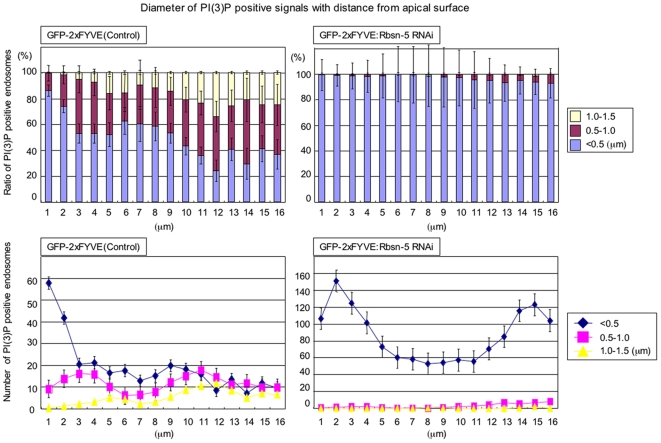
The number of basolateral large PI(3)P-positive endosomes was decreased in Rbsn-5 knockdown pupal wings.Ratios (upper) or numbers (lower) of small (<0.5 µm, blue), middle (0.5–1.0 µm, red) and large (1.0–1.5 µm, yellow) endosomes are shown for repeated 1 µm sections from the apical to basal region in the wild type (left), or Rbsn-5-knockdown (right) wings.